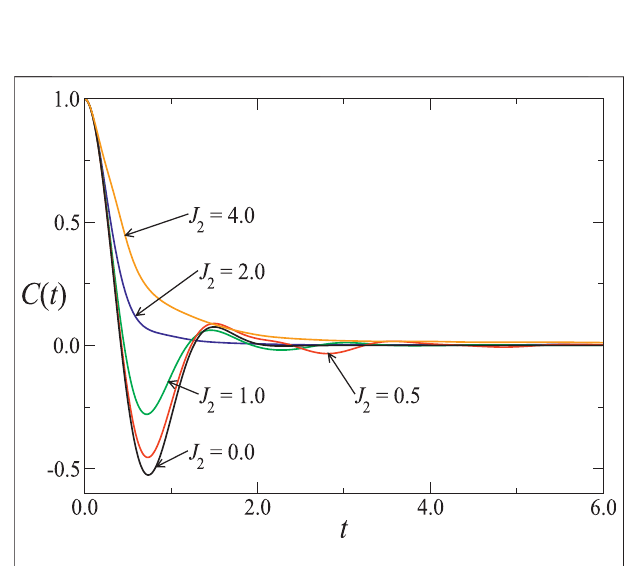
FIGURE7| Time-dependentcorrelationfunctionfor B (cid:2) 2 . 0andvarious values of J 2 . The chain size is L (cid:2) 13. [From Ref.